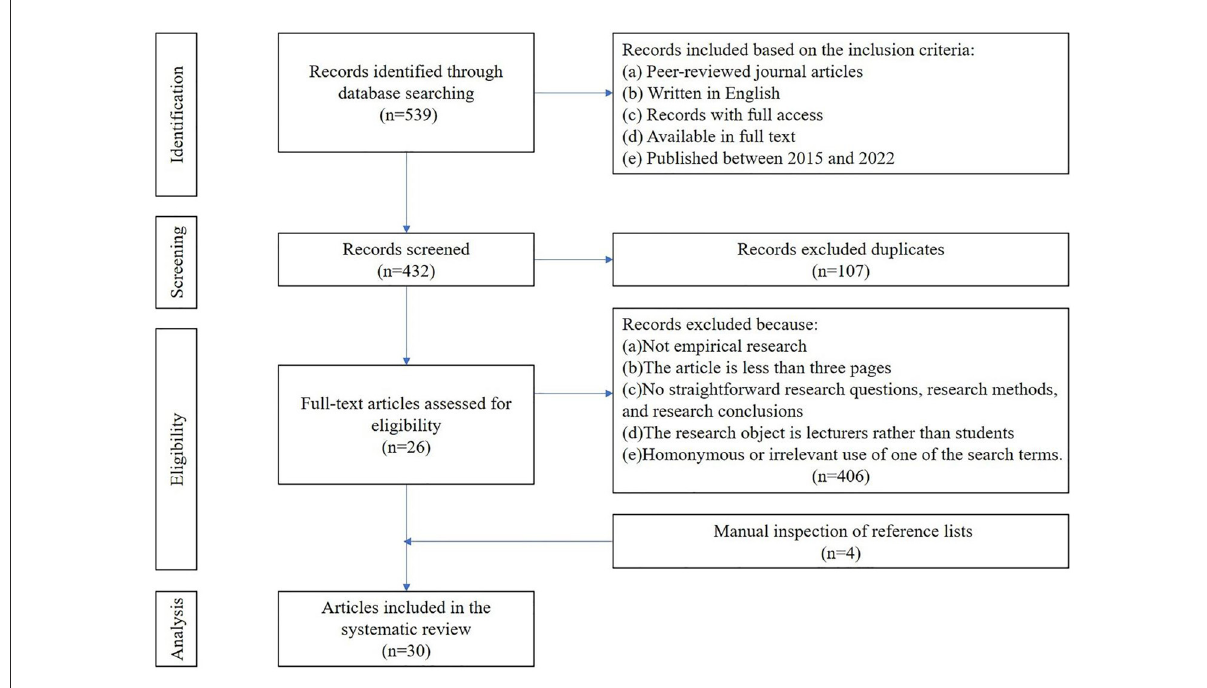
FIGURE1 Article selection process.